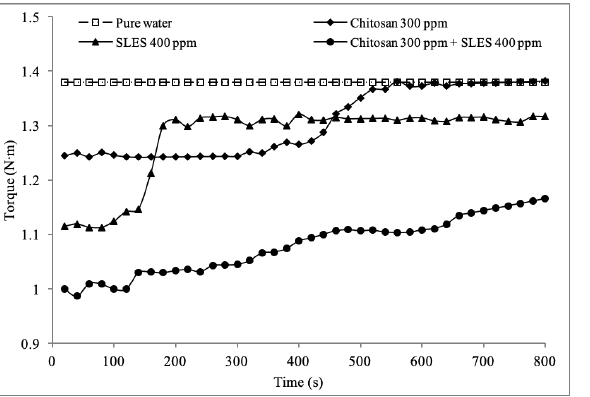
Figure 9: Stability test of chitosan–SLES complex, pure chitosan, and SLES for 800 seconds